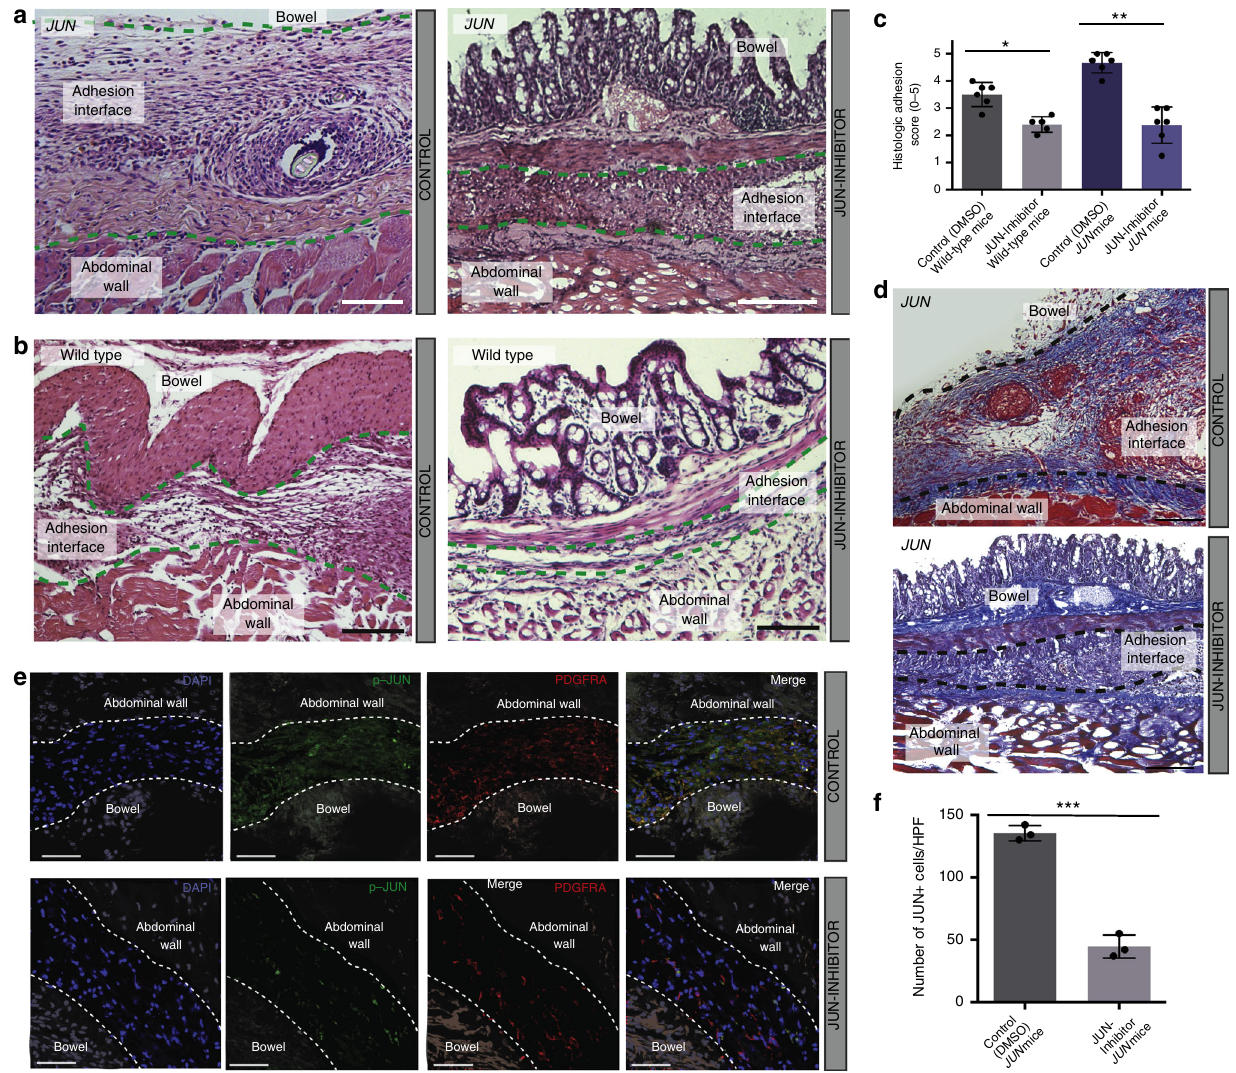
Fig. 6 Functional modulation of JUN regulates adhesion formation. a , b Representative H&E sections for vehicle control (left panels) and JUN-inhibitor- treated (right panels), in JUN (JUN expression induced with doxycycline in all JUN mice used) ( a ) and wild-type ( b ) mice. Adhesion interfaces outlined with green dotted lines. Structures as labelled in fi gure. Scale bars, 100 μ m. n = 5 biological replicates per condition per treatment. c Histologic scoring (as used in Fig. 1b) of adhesion tissue following in vivo inhibition of JUN using JUN inhibitor versus vehicle control in JUN (JUN expression induced with doxycycline in all JUN mice used) and wild-type mice. n = 5 biological replicates per condition per treatment. d Representative images of trichrome staining of JUN mouse vehicle control (top panel) and JUN-inhibitor-treated adhesion specimen (bottom panel). JUN expression induced with doxycycline in all JUN mice used. Adhesion interface outlined with black dotted lines. Structures as labelled in fi gure. n = 5 biological replicates per treatment. Conditions and structures at noted in fi gure panels. Scale bars, 100 μ m. e Representative fi gures showing IF staining for phospho-JUN and PDGFRA in adhesion tissue following in vivo inhibition of JUN (using JUN inhibitor, T-5224) in JUN ( JUN expression induced with doxycycline in all JUN mice used) mice. Conditions and structures at noted in fi gure. Scale bars, 50 μ m. f Quanti fi cation of p-JUN + cells in e . HPF high power fi eld. n = 3 biological replicates assessed per treatment condition, datapoints represent average of multiple measures per replicate. Data and error bars represent mean ± SD. * P = 0.001, ** P = 0.0001, *** P = 0.0001, unpaired two-tailed t -test. Source data are provided as a Source Data fi